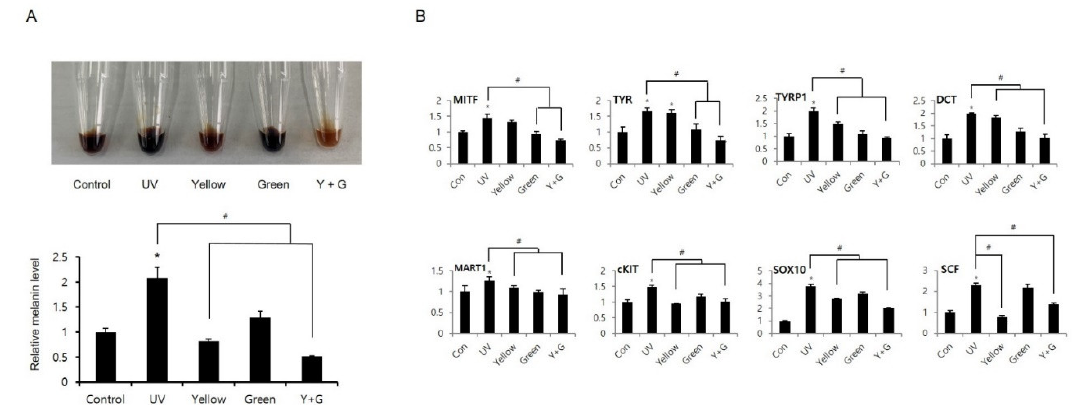
Figure 4. IPL treatment inhibits melanogenesis caused by UVB radiation in human epidermal melanocytes. Melanocytes were pretreated with UVB, and then IPL irradiation was performed. ( A ) The melanin accumulation levels were represented by the colors of the cell lysates, and the melanin content in the cell lysates was analyzed via spectrometry. ( B ) The expression of melanogenic genes was examined by RT-qPCR. The data are depicted as the means ± SDs of the values obtained in 3 independent analyses (N = 3). # p < 0.001 compared to the UVB-treated group; * p < 0.001 compared to the vehicle-treated (control) group.